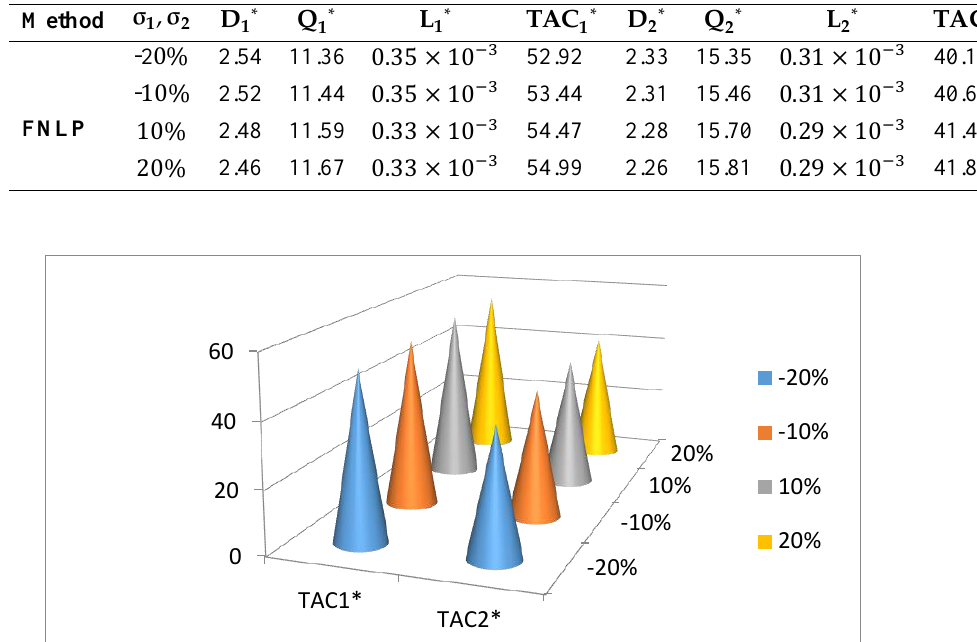
Fig. 6. Minimizing cost of 1 st and 2 nd items for different values of 𝛔 𝟏 , 𝛔 𝟐.